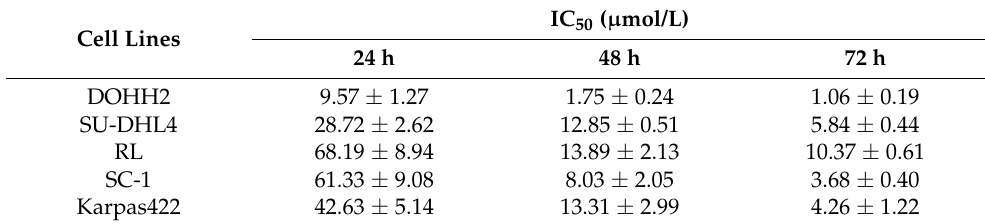
Table 1. The IC 50 values of chiauranib in t-FL cell